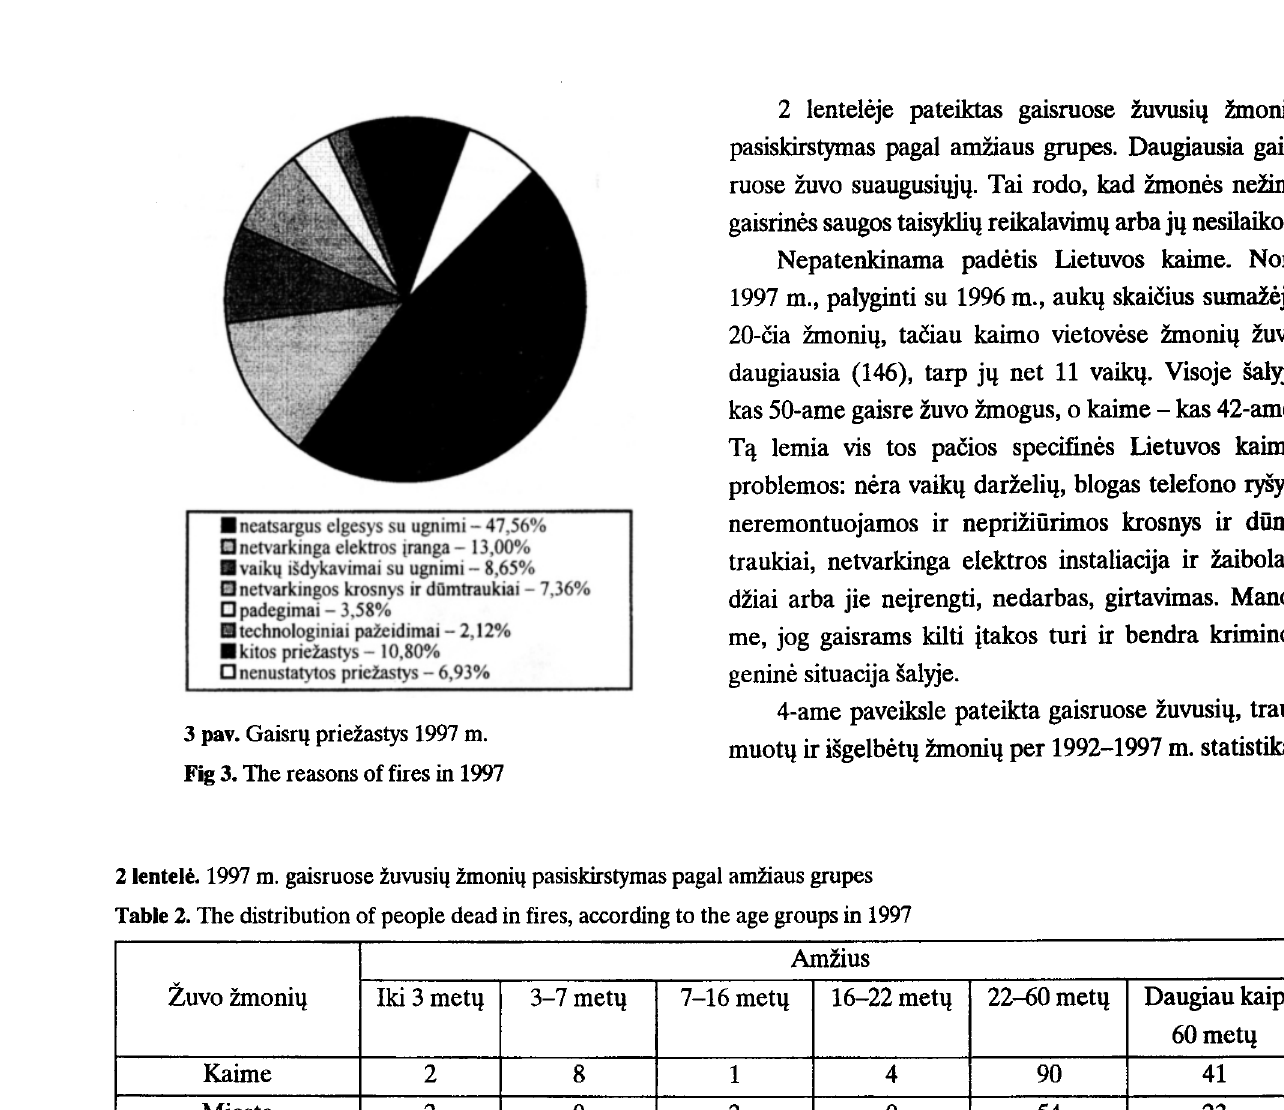
Table 2. The distribution of people dead in fires, according to the age groups in 1997 Zuvo2moniq Kaime Mieste IS viso salyje